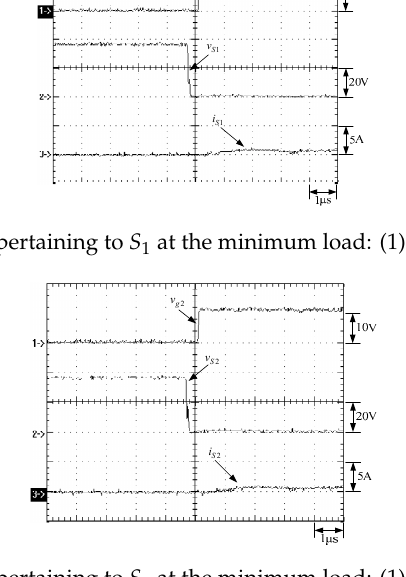
Figure 20. Waveforms pertaining to S 2 at the minimum load: (1) v g 2 ; (2) v S 2 ; and (3) i S 2 .